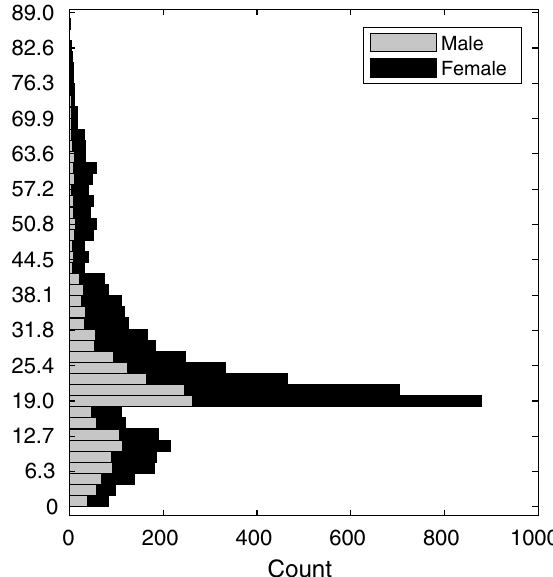
Figure 1. Demographics of the normative sample used in this study. This figure was generated in MATLAB 2021a (https:// www. mathw orks.